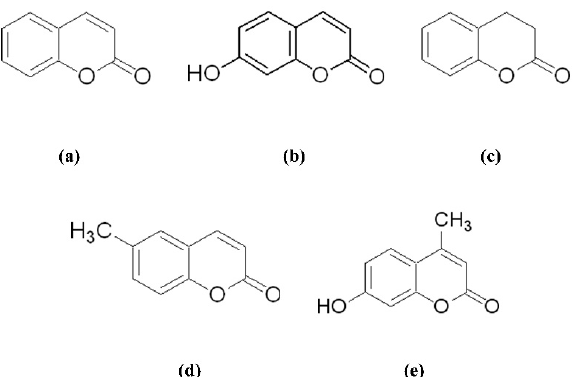
Figure 1. The chemical structures of the studied compounds. Coumarin ( a ), 7-hydroxycoumarin ( b ), dihydrocoumarin ( c ), 6-methylcoumarin ( d ), and 4-methylumbelliferone ( e ).